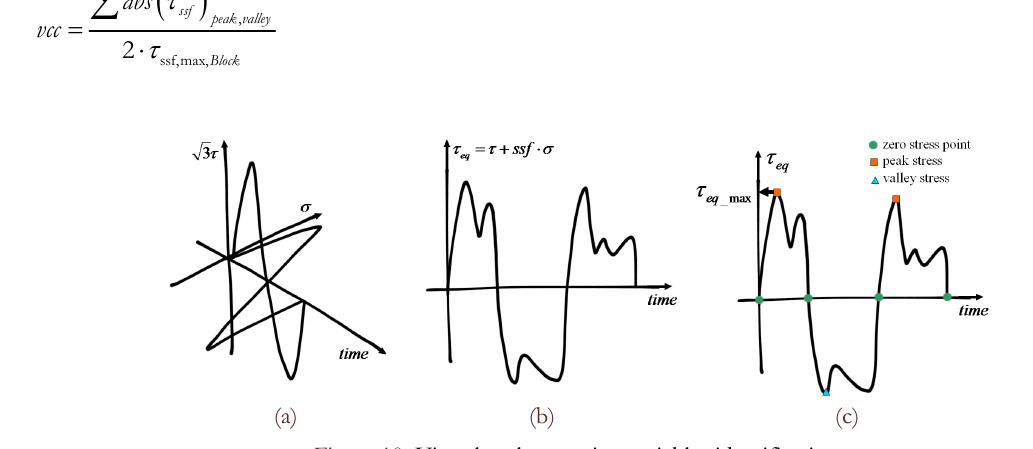
Figure 10 : Virtual cycle counting variables